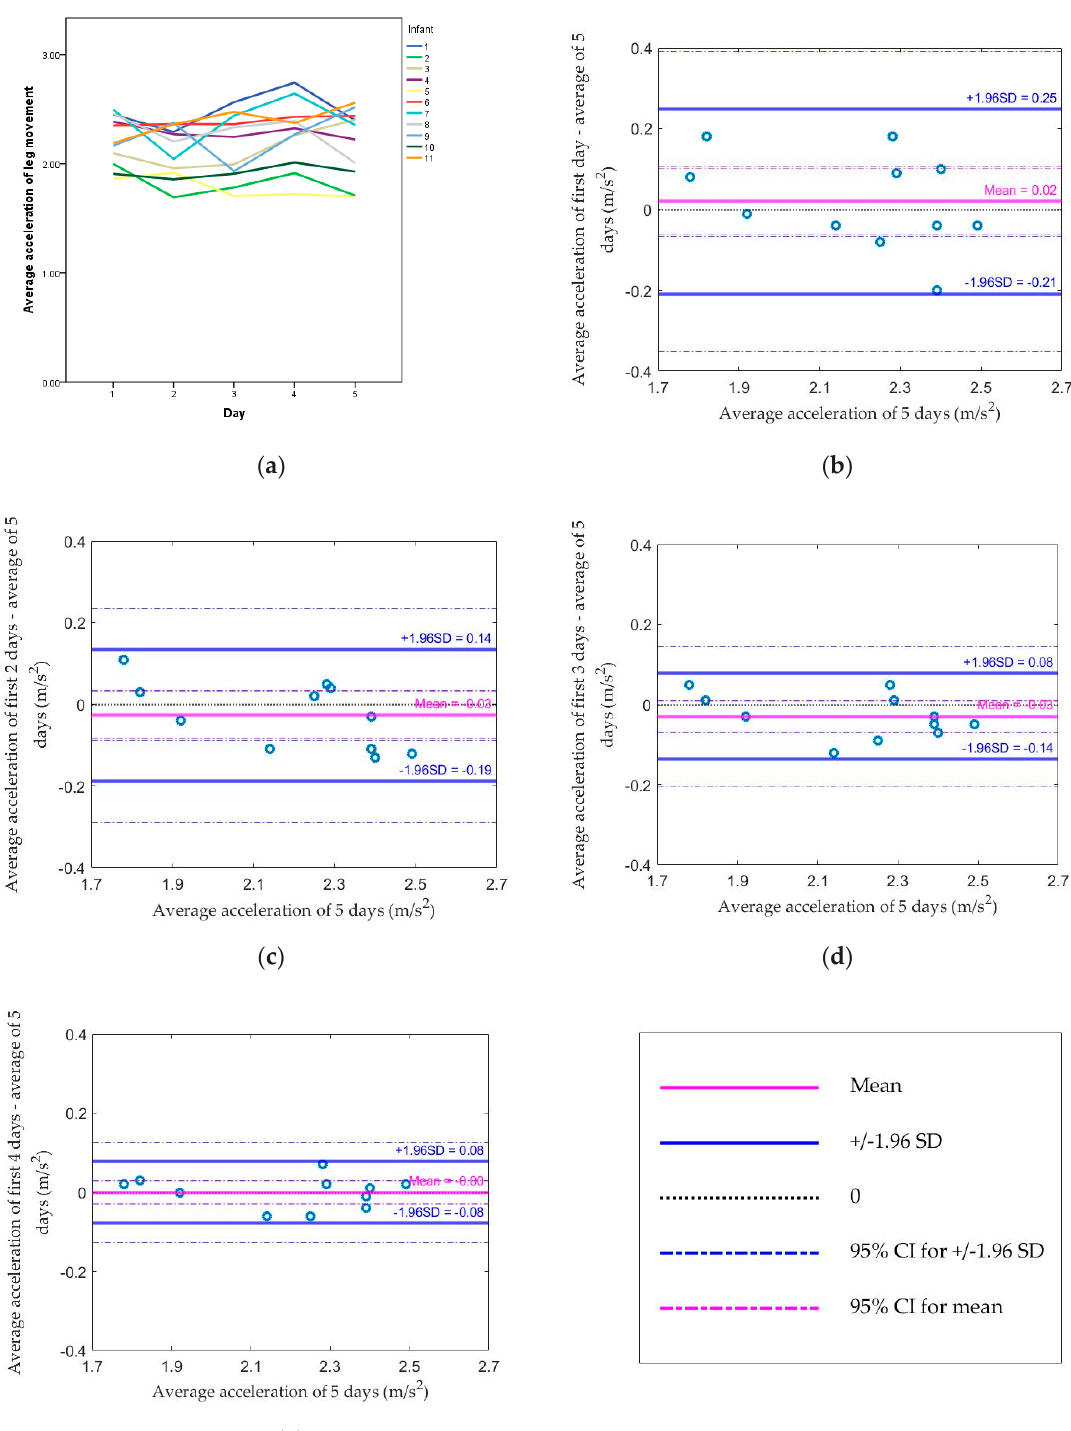
Figure 3. ( a ) Average acceleration of leg movement from the first day to the fifth day for each infant; Bland–Altman plots comparing ( b ) the first day, ( c ) the average of the first 2 days, ( d ) the average of the first 3 days, ( e ) the average of the first 4 days, and the average of 5 days for the average acceleration of leg movement.